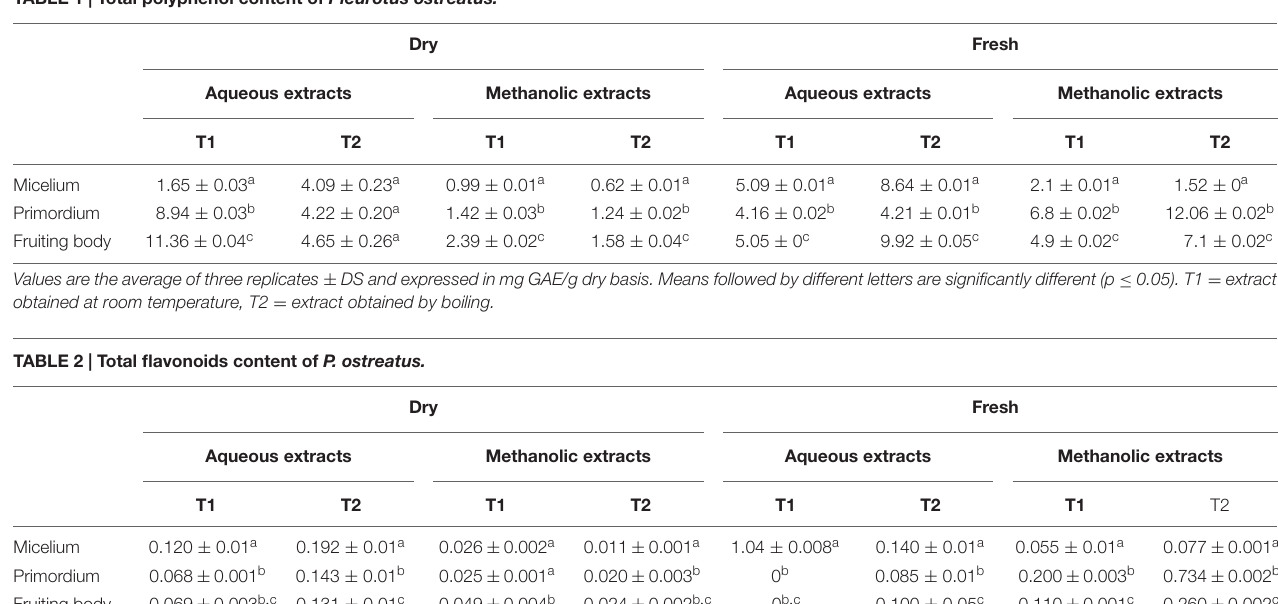
TABLE 1 | Total polyphenol content of Pleurotus ostreatus.